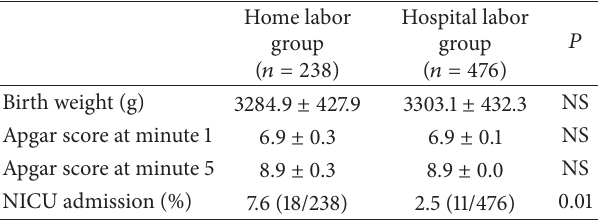
Table 2: Comparisons of certain neonatal outcomes of pregnancies with home and hospital labor.